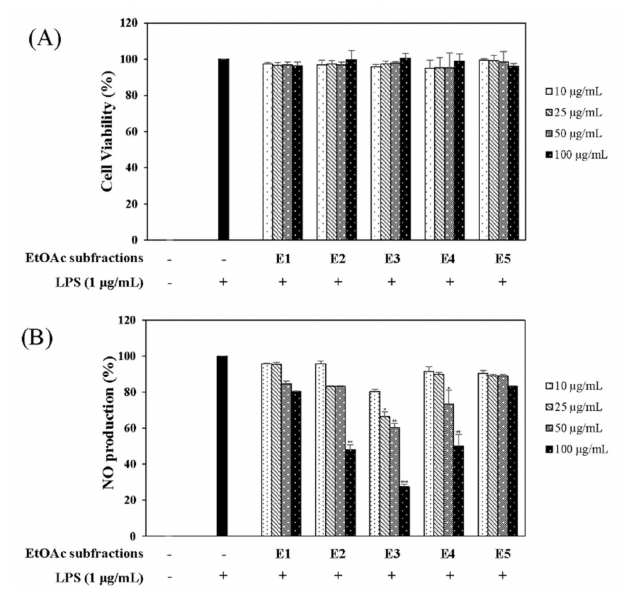
Figure 2. E ff ects of ethyl acetate (EtOAc) subfractions (E1–E5) on cell viability ( A ) and NO production ( B ). RAW 264.7 cells were cultured in the presence of the N. domestica extract for 1 h and stimulated with LPS (1 µ g / mL) for 16 h. Cell viabilities and NO production were detected using the MTT assay and the Griess reagent, respectively. Nitrite concentrations of non-treated and LPS-treated controls were 0.8 ± 0.04 µ M and 17.5 ± 0.3 µ M, respectively. Each experiment was performed in triplicate. The